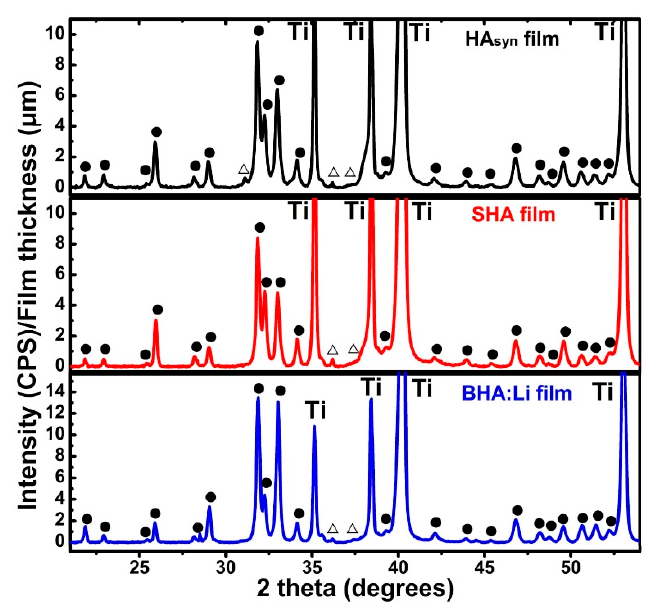
Figure 5. Comparative XRD patterns of synthetic and BioHA coatings synthesized by PLD onto titanium substrates ( ● , HA; ∆ , TiO, and Ti 2 O sub-oxides). Reprinted from Reference [53], with permission from Elsevier.